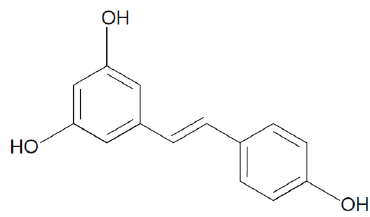
Figure 10. Chemical structure resveratrol.